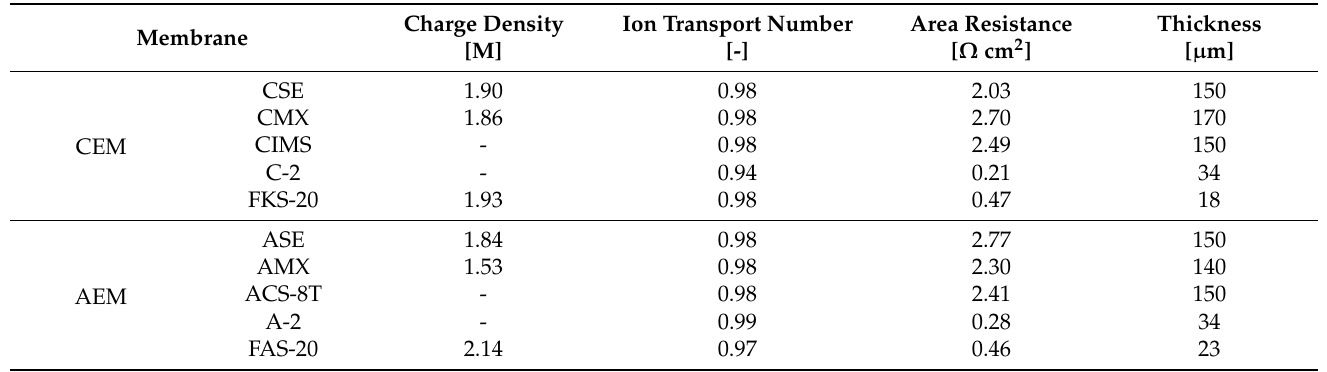
Table 1. Basic properties of IEMs used in this study.